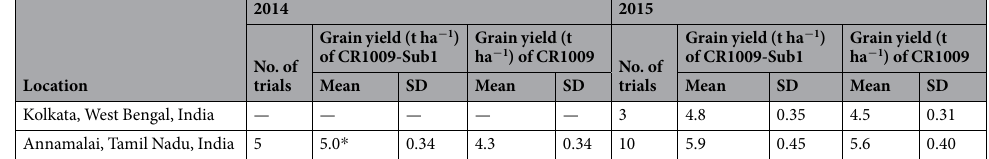
Table 3. Yield comparison of CR1009-Sub1 and CR1009 in head to head trials during the wet seasons of 2014 and 2015. * Indicates that the grain yield is significantly higher than the parental variety at level, p = 0.05.